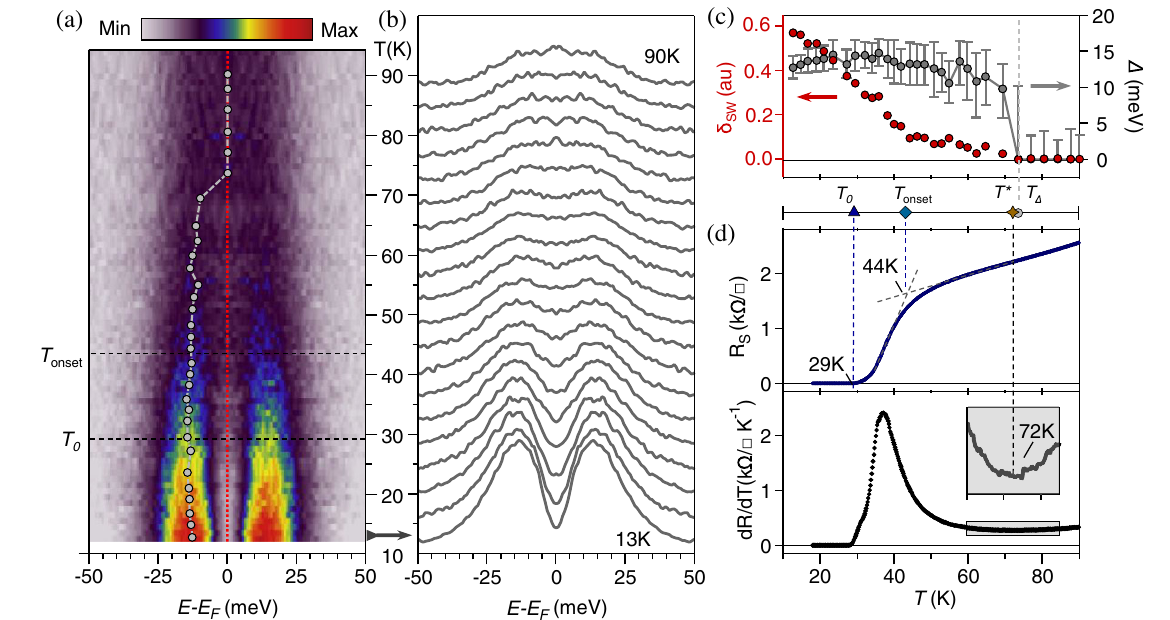
FIG. 2. Comparison of temperature-dependent gap closing behavior and corresponding resistive superconducting transition. (a) Symmetrized EDCs taken at k F from over 100 individual spectra collected between 12 and 94 K. The color scale indicates the EDC intensity, with increasing temperature along the vertical axis. The gray circles track the quasiparticle peak position as a function of the temperature. (b) Selection of symmetrized EDCs from the data in (a). The temperature (vertical) axis is matched to that of (a). (c) Extracted energy gap Δ (right axis) as a function of the temperature from the data in (a). Δ is defined as half of the separation between the EDC peak positions indicated in (a). The red symbols (left axis) track the suppression spectral weight δ SW at E F [dotted line in (a)] relative to 90 K. (d) Sheet resistance (blue line, top) and dR=dT (black line, bottom) as a function of the temperature measured in situ for the same sample presented in (a) and